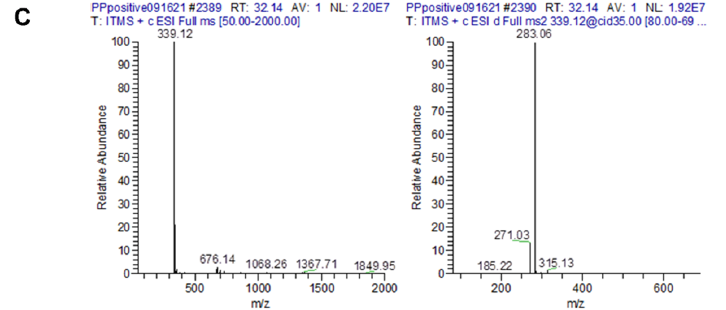
Figure 3. Purification of isowighteone. ( A ) HPLC chromatogram of ethyl acetate extract from the medium of pigeon pea hairy root culture. ( B ) HPLC chromatogram of purified isowighteone with its UV spectrum and chemical structure. All chromatograms were monitored at 260 nm. ( C ) HPLC ‐ PDA ‐ electrospray ionization ‐ MS 2 analysis of isowighteone (left: MS; right: MS 2 ).